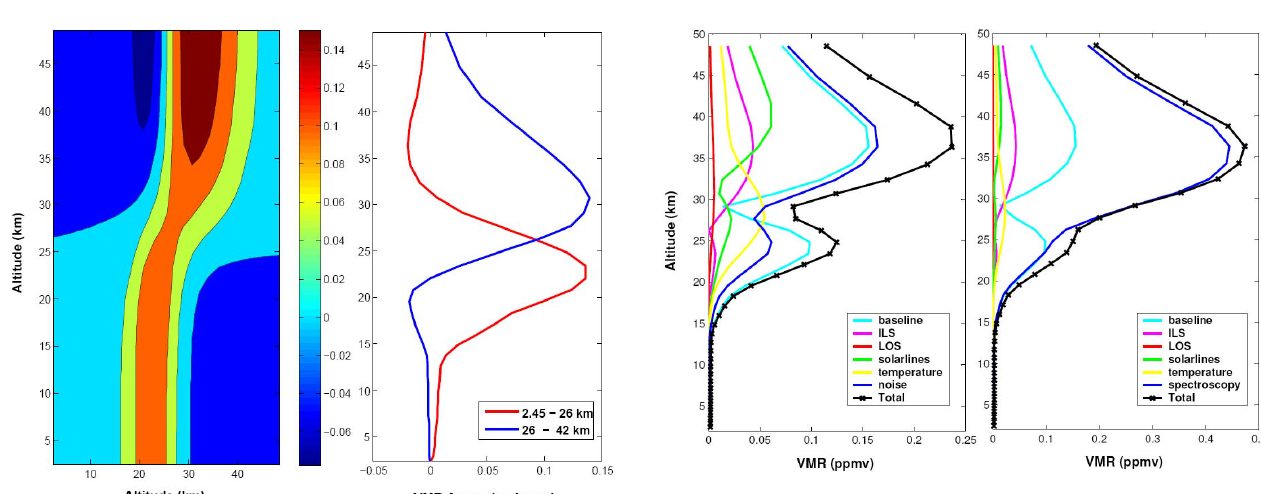
Fig. 4. Error budget of O 3 retrieval from solar spectra taken by FTIR. Left: estimated uncertainty profiles for statistical error. Right: systematic error